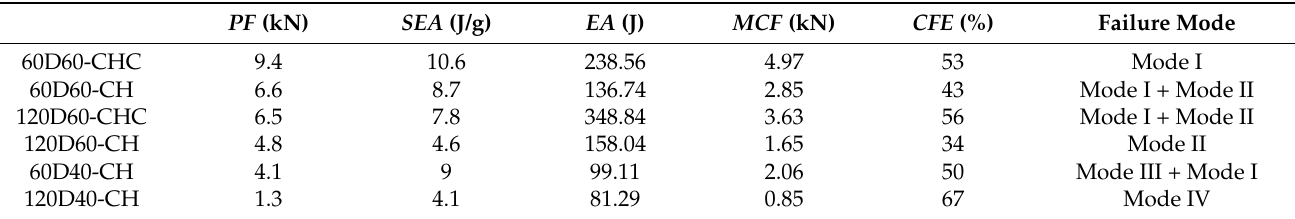
Table 3. Summary of crashworthiness indicators and failure modes of